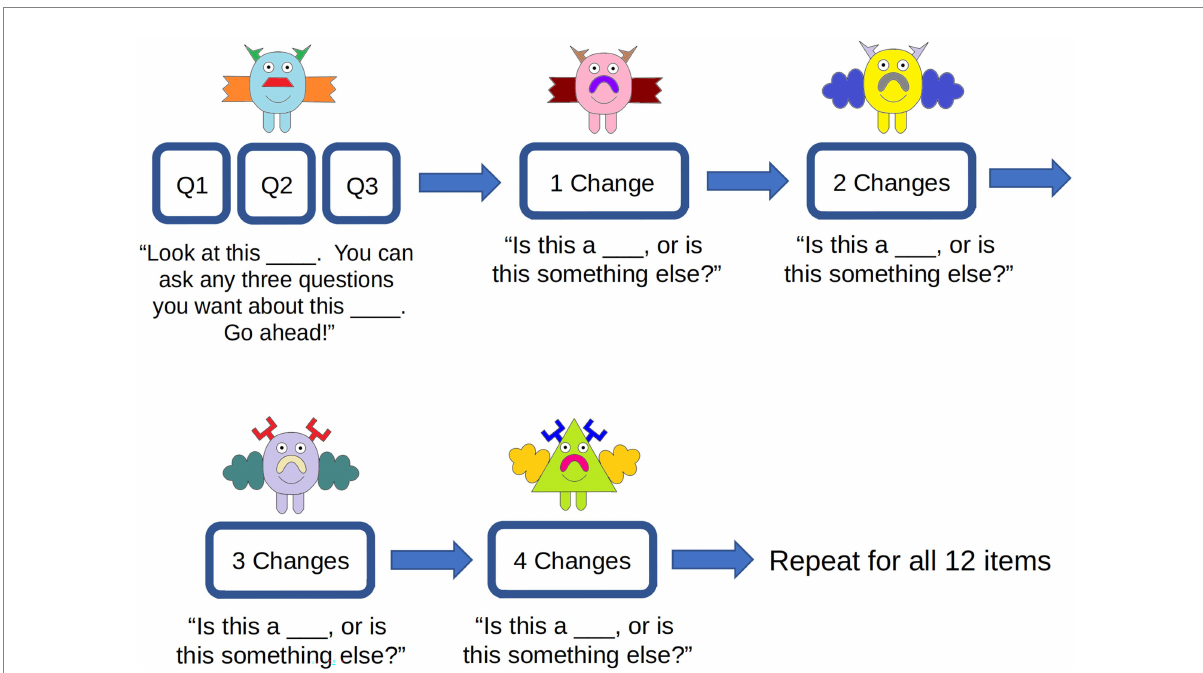
FIGURE 5 Examples of stimuli and procedure for Experiment 2. Participants asked three questions about a novel object, completed four categorization trials for that novel object, then repeated this procedure for all 12 novel